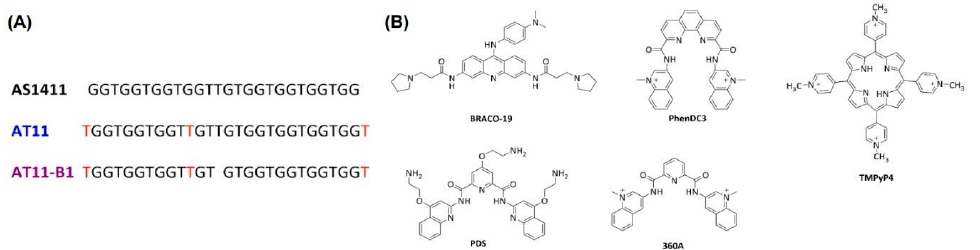
Figure 1. ( A ) AT11-B1, AT11 and AS1411 (modifications shown in red) sequences. ( B ) Chemical structure of the G4 G4 ligands.